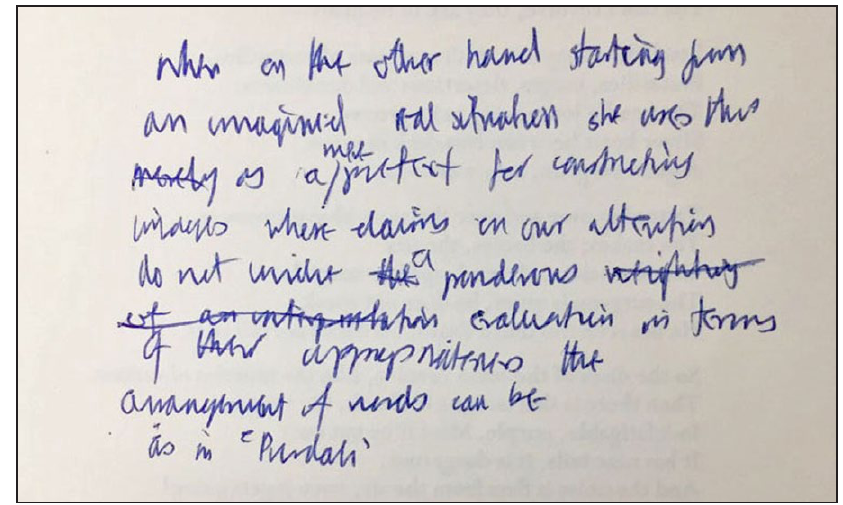
Figure 1: Veronica Forrest-Thomson’s annotation to Sylvia Plath’s ‘Purdah’, in her copy of Winter Trees